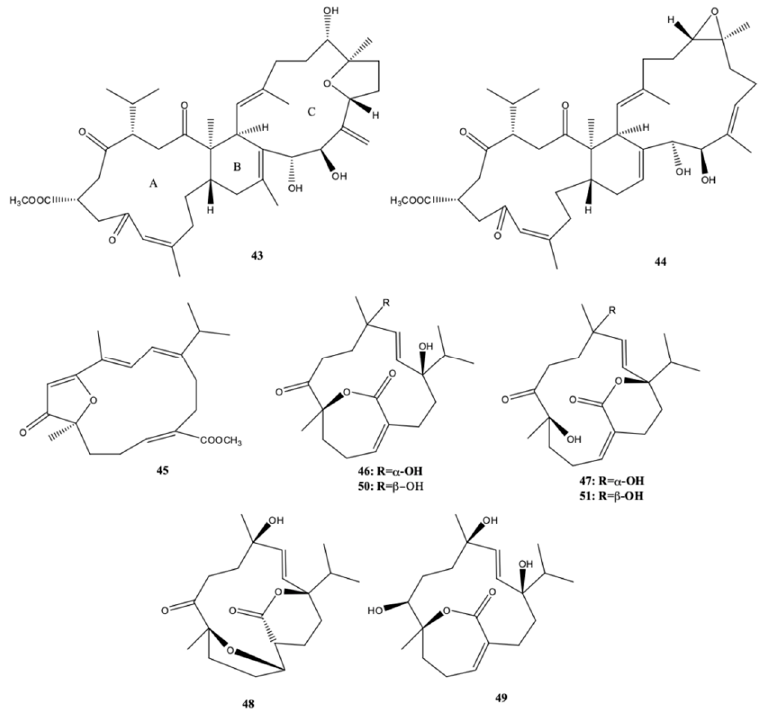
Figure 6. Biscembranoids and cembranoid diterpenes isolated from Sarcophyton elegans , collected at Xisha Islands in the South China Sea [22].